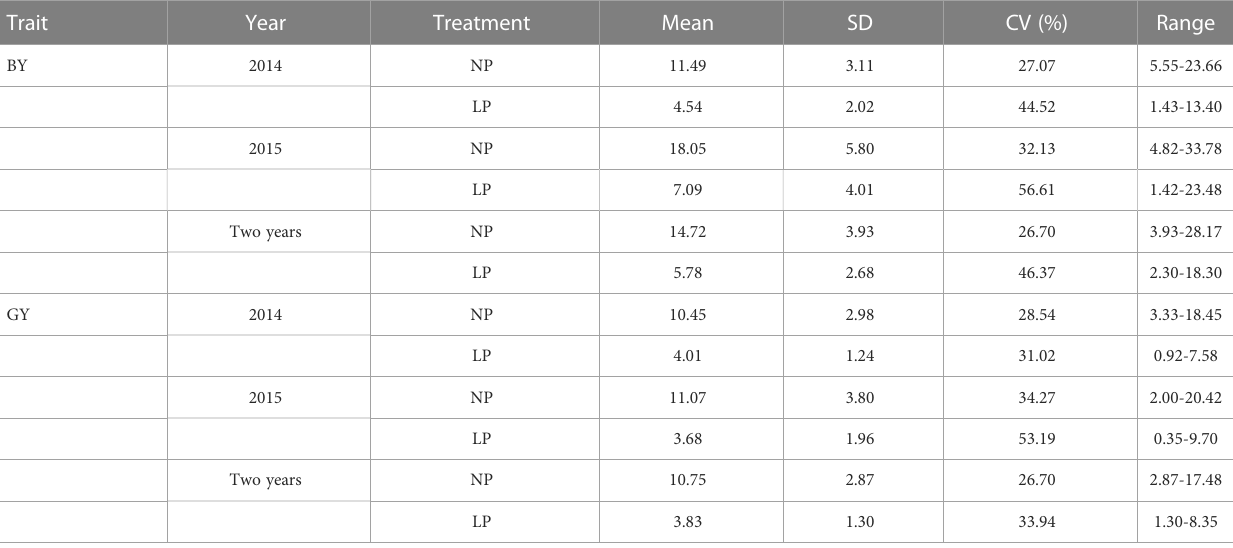
TABLE 1 Descriptive statistical results for traits under normal and low Pi supply in the natural population in the fi eld experiments conducted in 2014 and 2015. Trait Year Treatment Mean SD CV (%) Range